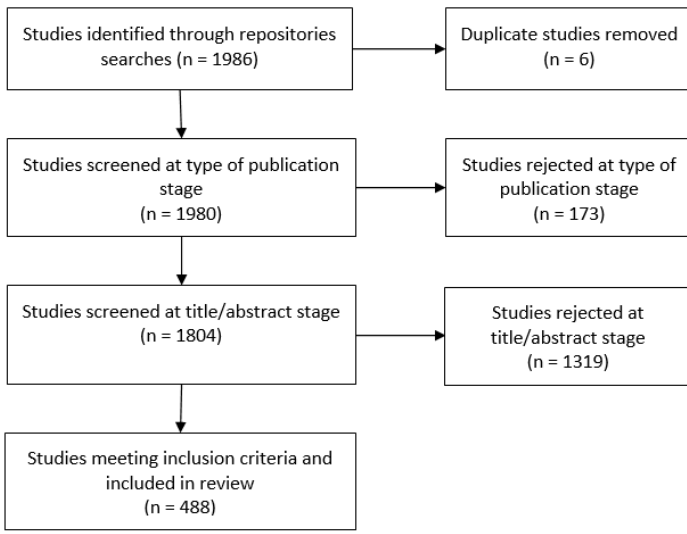
Figure 1. Selection and review process.